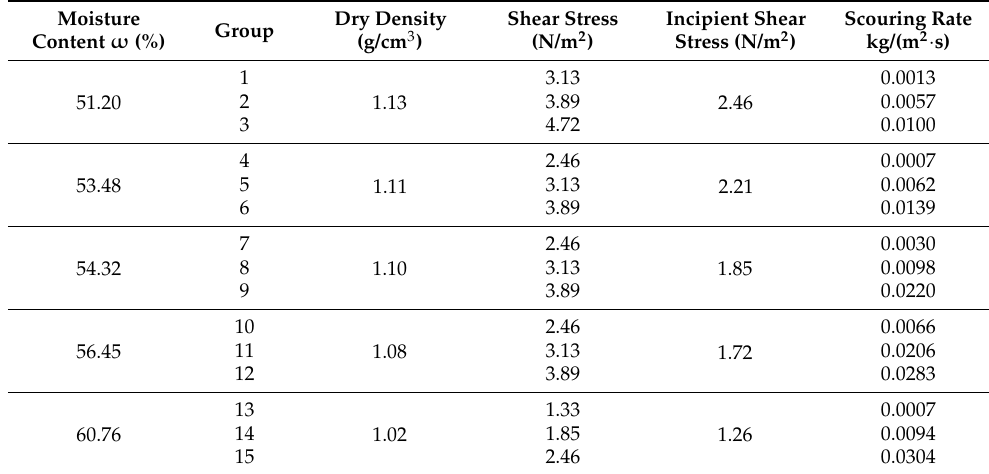
Table 2. Test results of the scouring rate of cohesive soil sample 1.